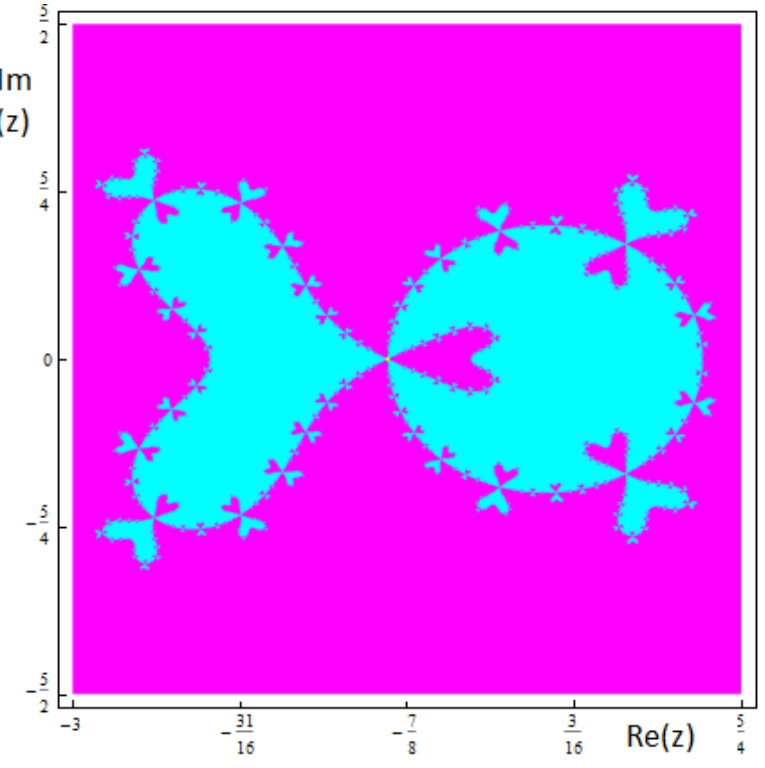
Figure 5. Basins of attraction associated to the member of the family a 0 = − 5 and a 1 = − 4.